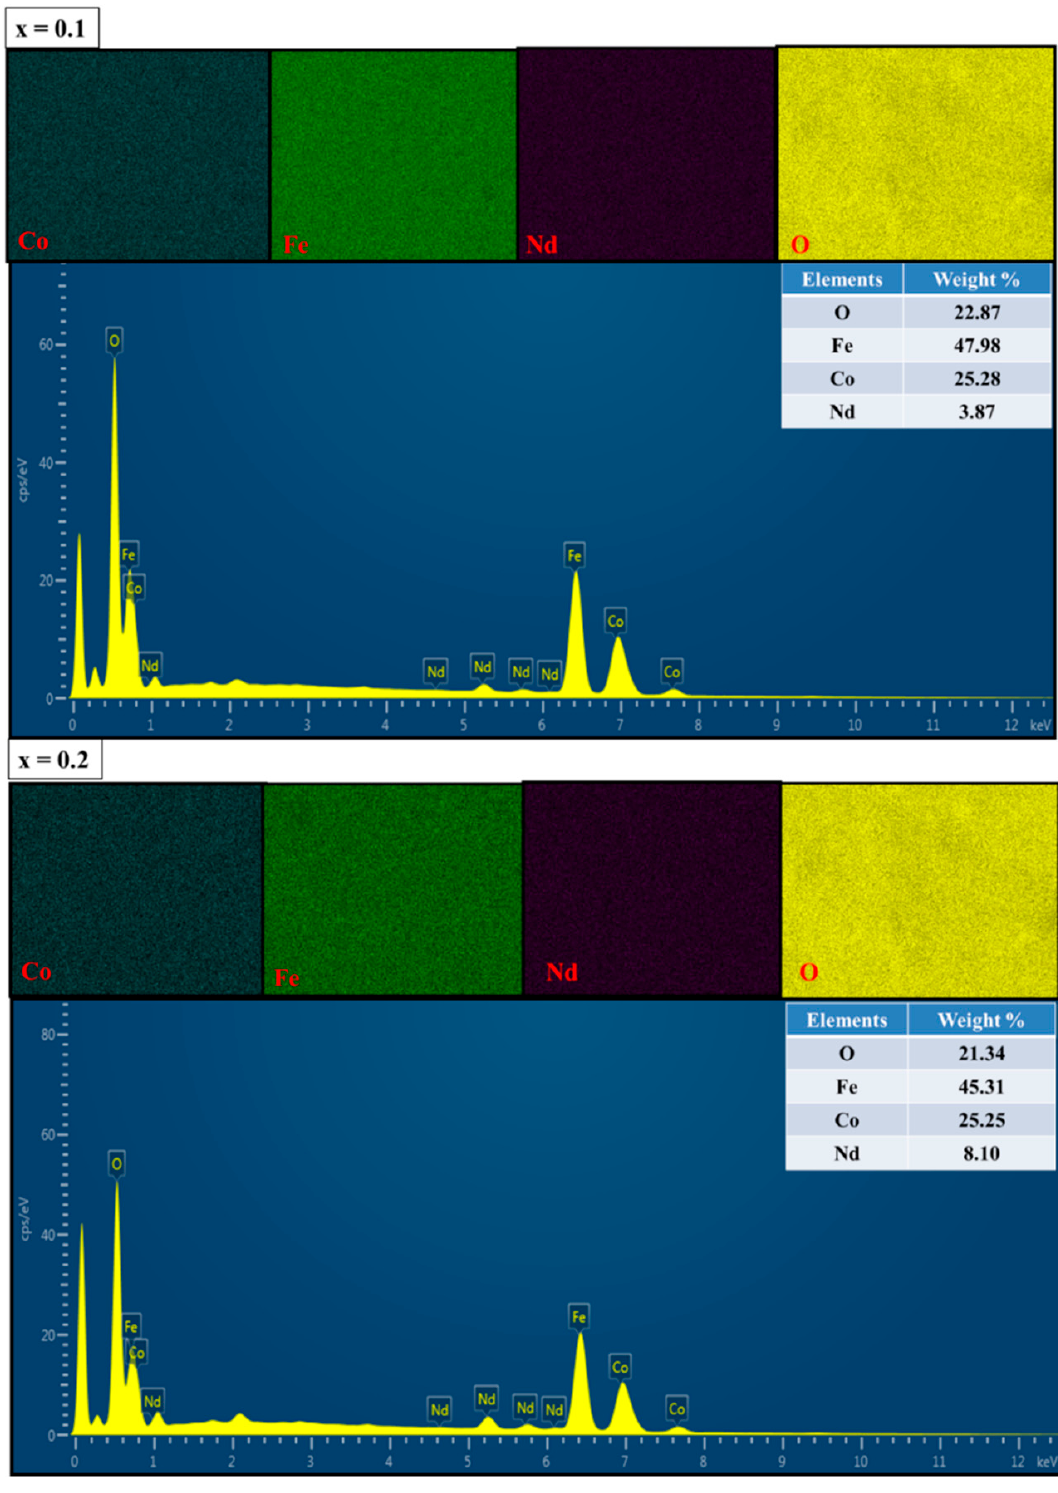
Figure 3. EDX spectra of CoNd x Fe 2 − x O 4 (0.0 ≤ x ≤ 0.2) NPs.